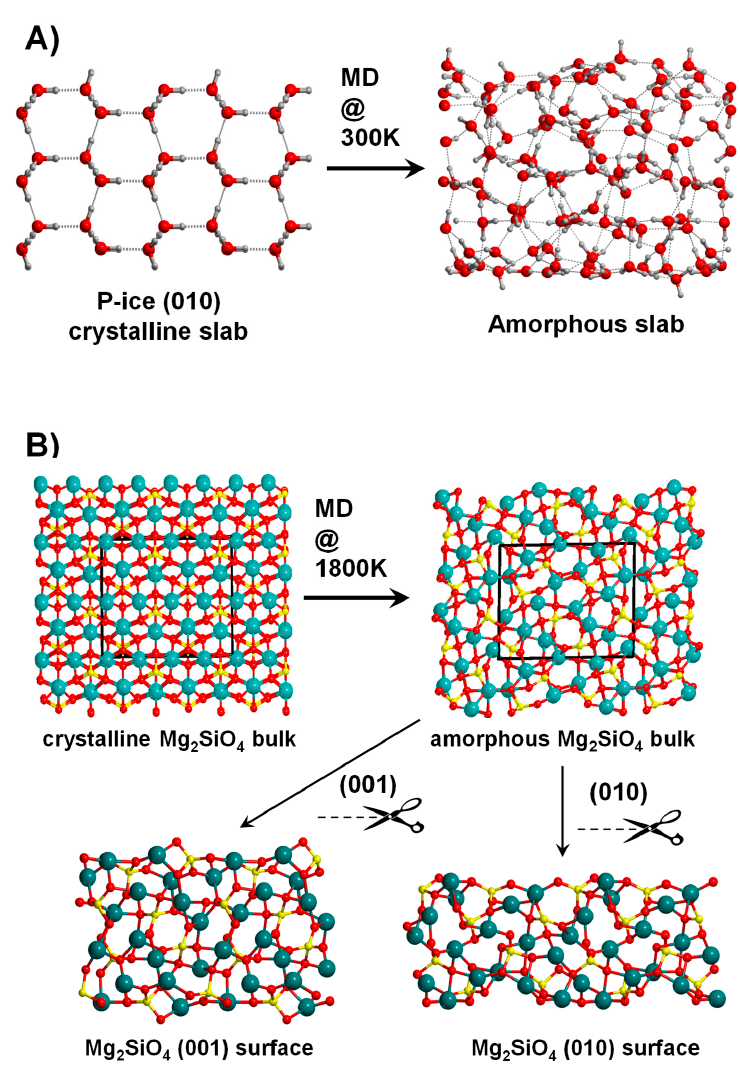
Figure 3. ( A ) Generation of an amorphous H 2 O P-ice slab surface model by running molecular dynamic (MD) simulations at 300 K using the corresponding crystalline (010) slab model as the initial structure. ( B ) Generation of amorphous Mg 2 SiO 4 surfaces through a two-step process: (i) running MD simulations at 1800 K using as initial structure the crystalline Mg 2 SiO 4 bulk system to reach an amorphous Mg 2 SiO 4 bulk structure, and (ii) application of the slab-cut procedure onto the amorphous Mg 2 SiO 4 bulk to obtain the (001) and (010) amorphous slab surface models.